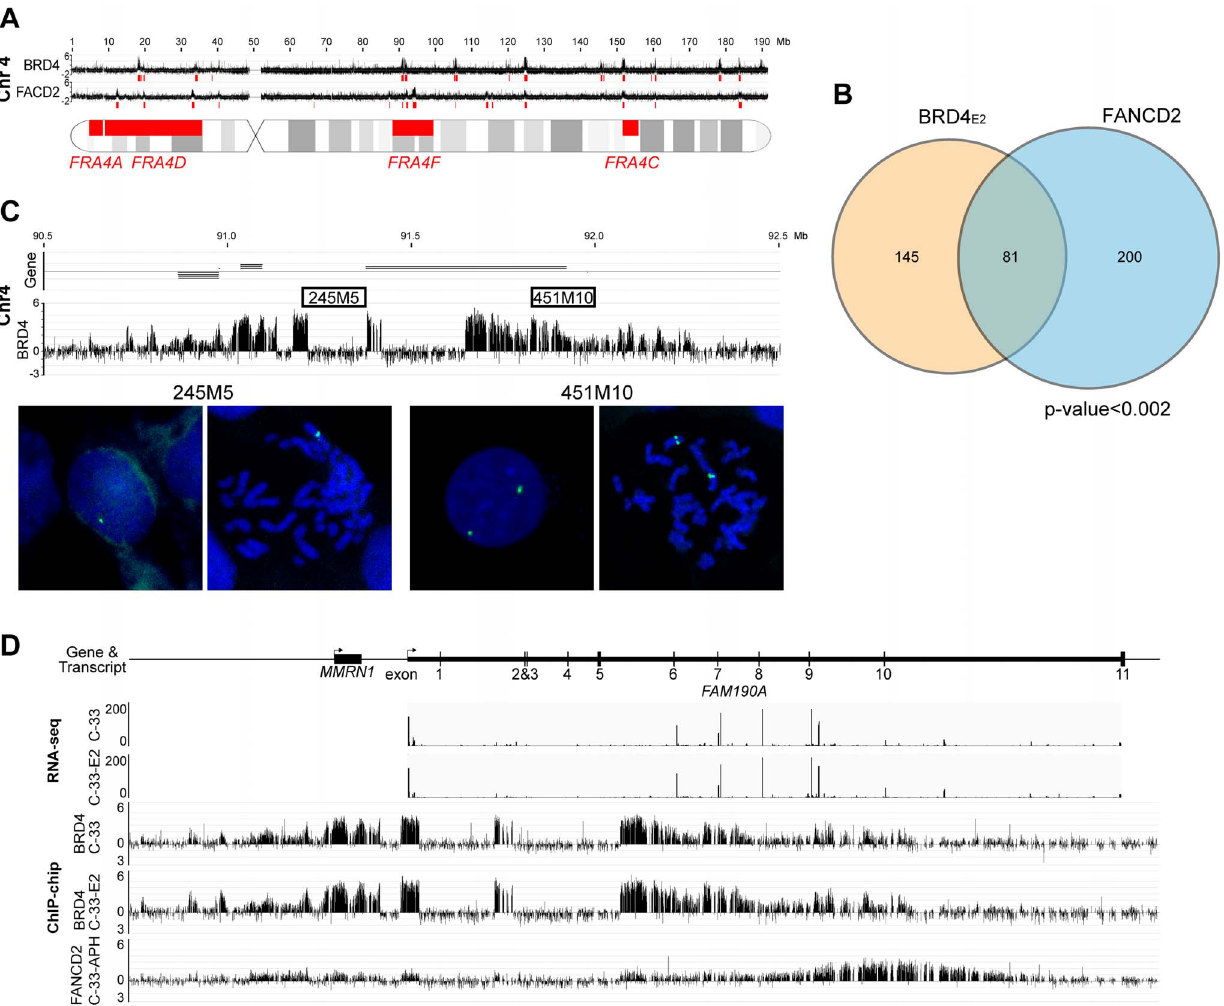
Figure 6. PEB-BLOCs are closely associated with common fragile sites. A. An alignment of BRD4 enriched regions (PEB-BLOCs), FANCD2 enriched regions and known common fragile sites on chromosome 4. The red blocks under the signalmap represent computationally defined enriched regions. B. Venn diagram showing the overlap in PEB-BLOCs and FANCD2 enriched regions in the entire human genome. The significance of overlap was calculated by the permutation method. C. Binding profile of BRD4 in C-33-1E2 cells on PEB-BLOC Chr4-P4, which overlaps the known common fragile site FRA4F . FISH analysis with 245M5 or 451M10 probes on interphase and mitotic cells reveal a deletion one allele overlapping the 245M5 probe. D. RNAseq analysis of the long FAM190A gene in Chr4-P4 PEB-BLOC. Reads of transcripts were aligned with BRD4 ChIP-chip binding data from C-33 and C-33-1E2 cells and FANCD2 binding data from aphidicolin treated C-33 cells.